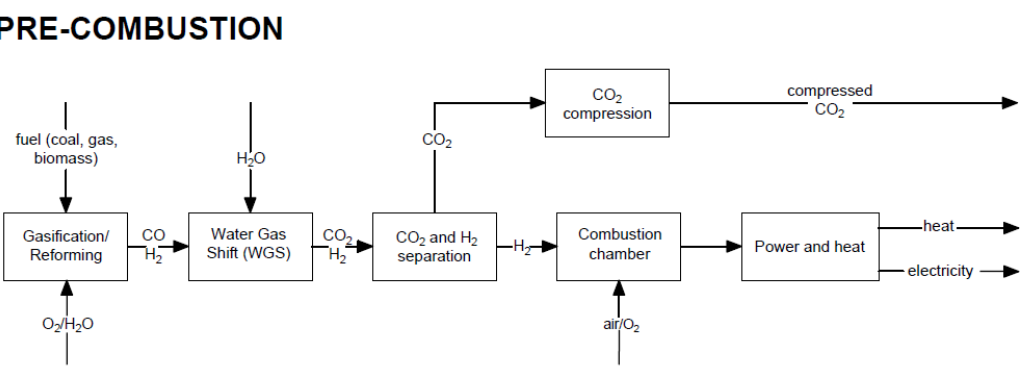
Figure 2. Block diagram of electricity generation heat production with the use of the pre-combustion CO 2 capture method. CO 2 capture